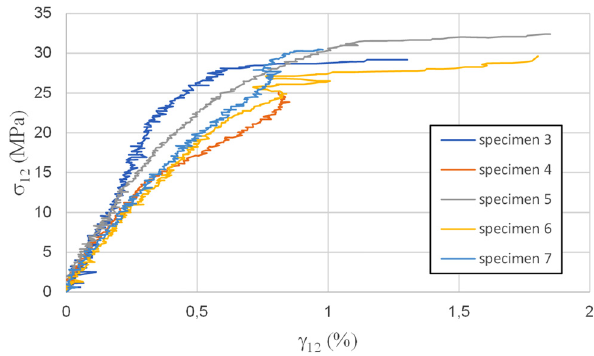
Figure 7: Experimental curves ( σ 12 vs γ 12 ) for samples 3 –